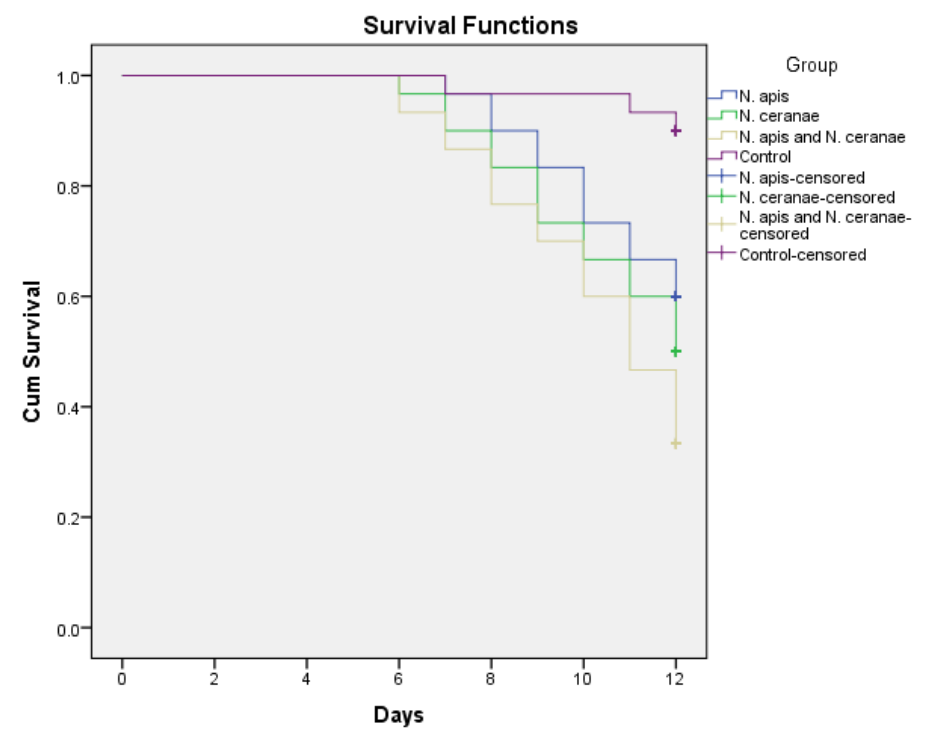
Figure 1. Cumulative survival of newly emerged worker honeybees inoculated with 10 6 Nosema spores/bee (single and mixed infection) or not inoculated (control group). Survival functions were estimated with the Kaplan–Meier method.